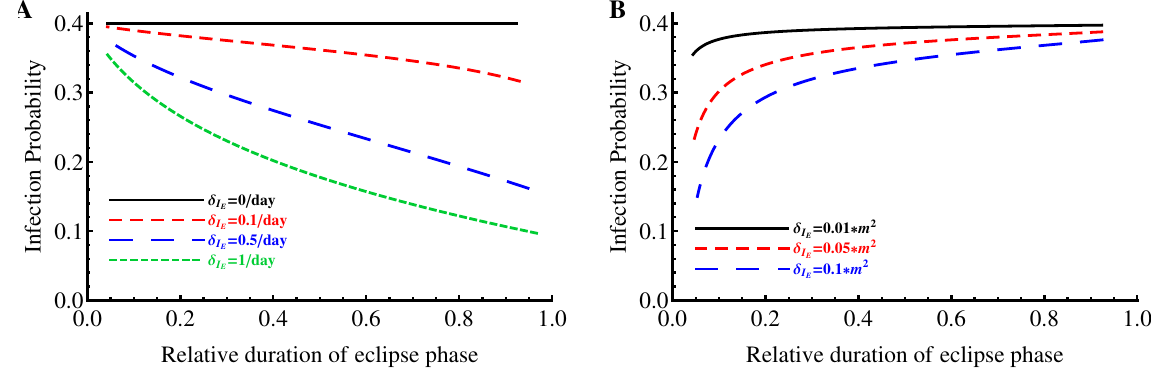
Figure 5. Variable dependence of the probability of infection p on the relative duration inf of the eclipse phase, T . Values for c , βT , and N are fixed according to Table 1 and the m maturation rate, m , is varied for four different fixed values of the death rate of cells in = θm 2 , panel B). the eclipse phase δ (panel A) or when m and δ are correlated ( δ I E I E I E For a given pair of these parameters, the value of the death rate of virus-producing cells, δ , is computed using Equation (10). The probability of established infection, p , and the I inf relative duration of eclipse phase, T , are found using Equations (4) and (13) , m